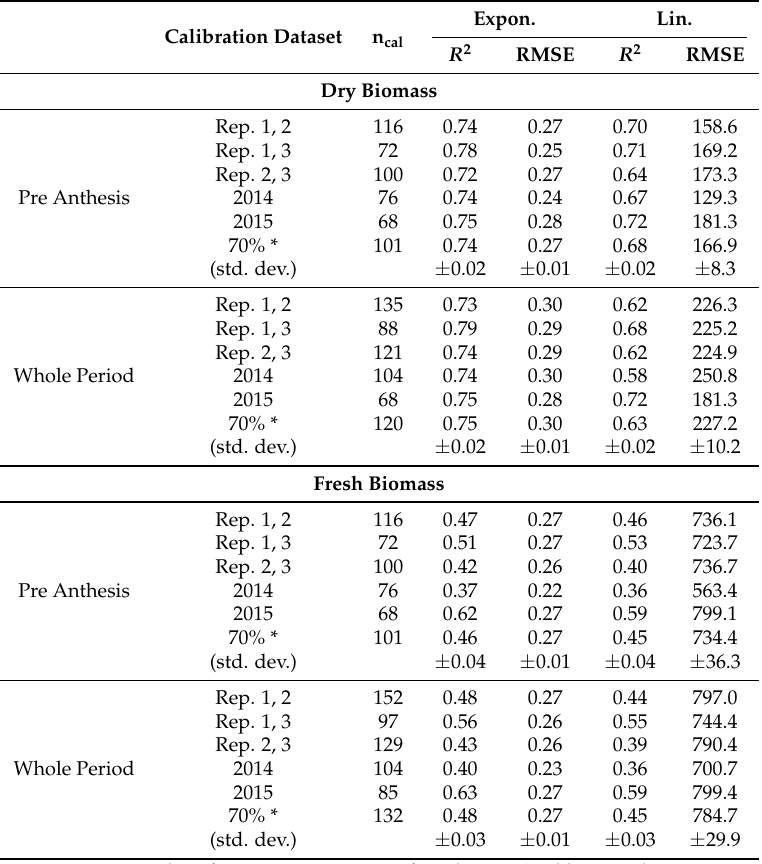
Table 3. Statistics of model calibration for regression of CSM-derived plant height against biomass, n cal : number of samples in calibration dataset; R 2 : coefficient of determination; RMSE: root mean square error.